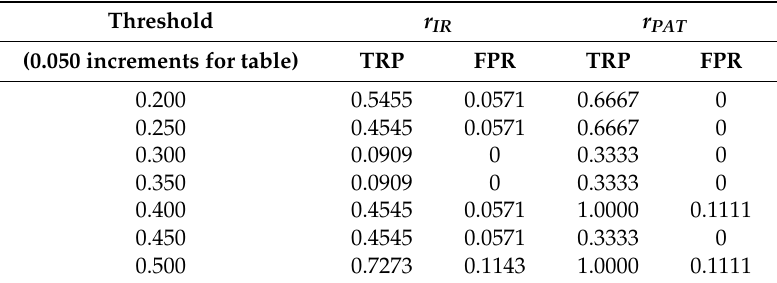
Table 3. Summary of Parameters for Selected